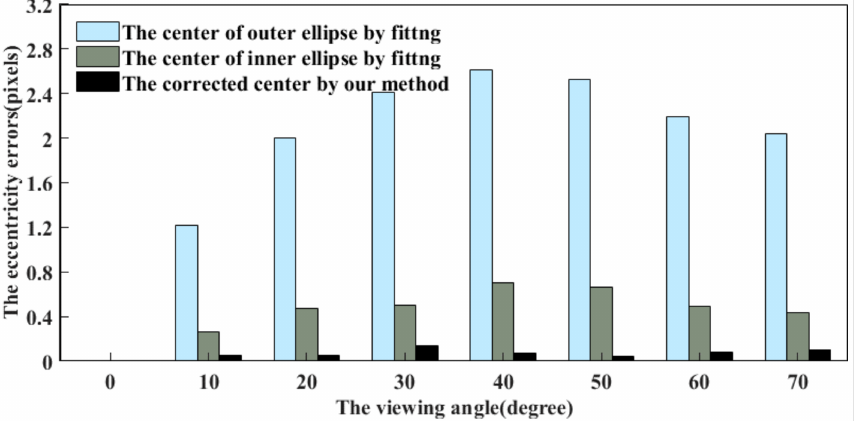
Figure 14. For different viewing angles, the eccentricity errors of the centers of the outer and inner ellipses using the fitting method in comparison with that of the CCCT corrected center by our